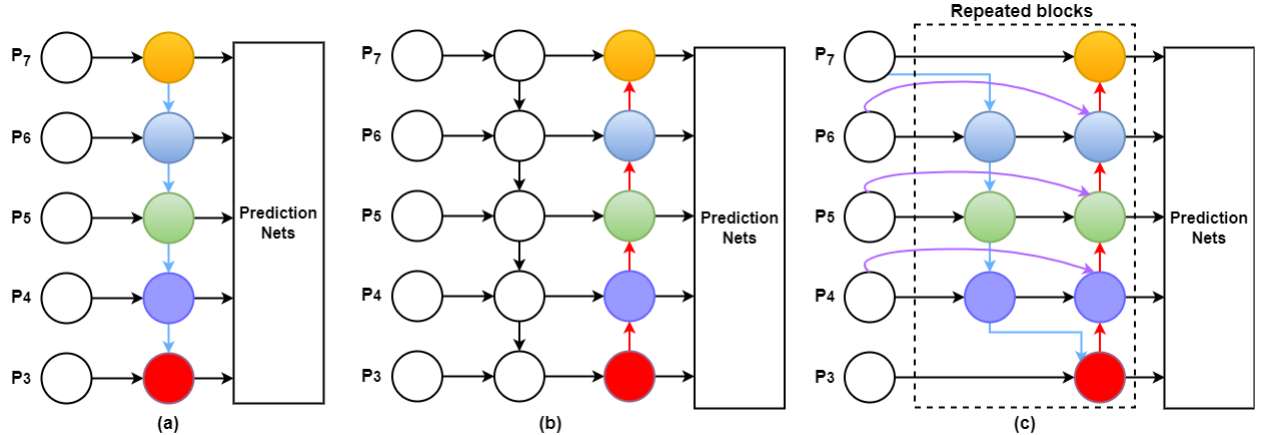
Figure 6. Structures of FPN, PANet, and Bi-FPN: ( a ) FPN [64] presents a top-down pathway ( b ) PANet [61] adds an extra bottom-up pathway on top of FPN; ( c ) Each top-down and bottom-up path is considered as a separate layer in Bi-FPNs feature network. The same layer is repeated multiple times to facilitate more sophisticated feature fusion.